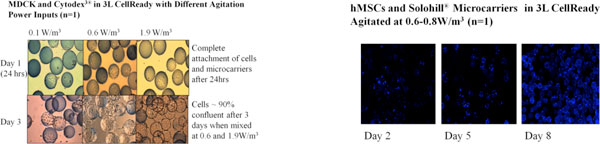
Illustrates the attachment of MDCK and hMSCs to Cytodex3® and Solohill® microcarriers